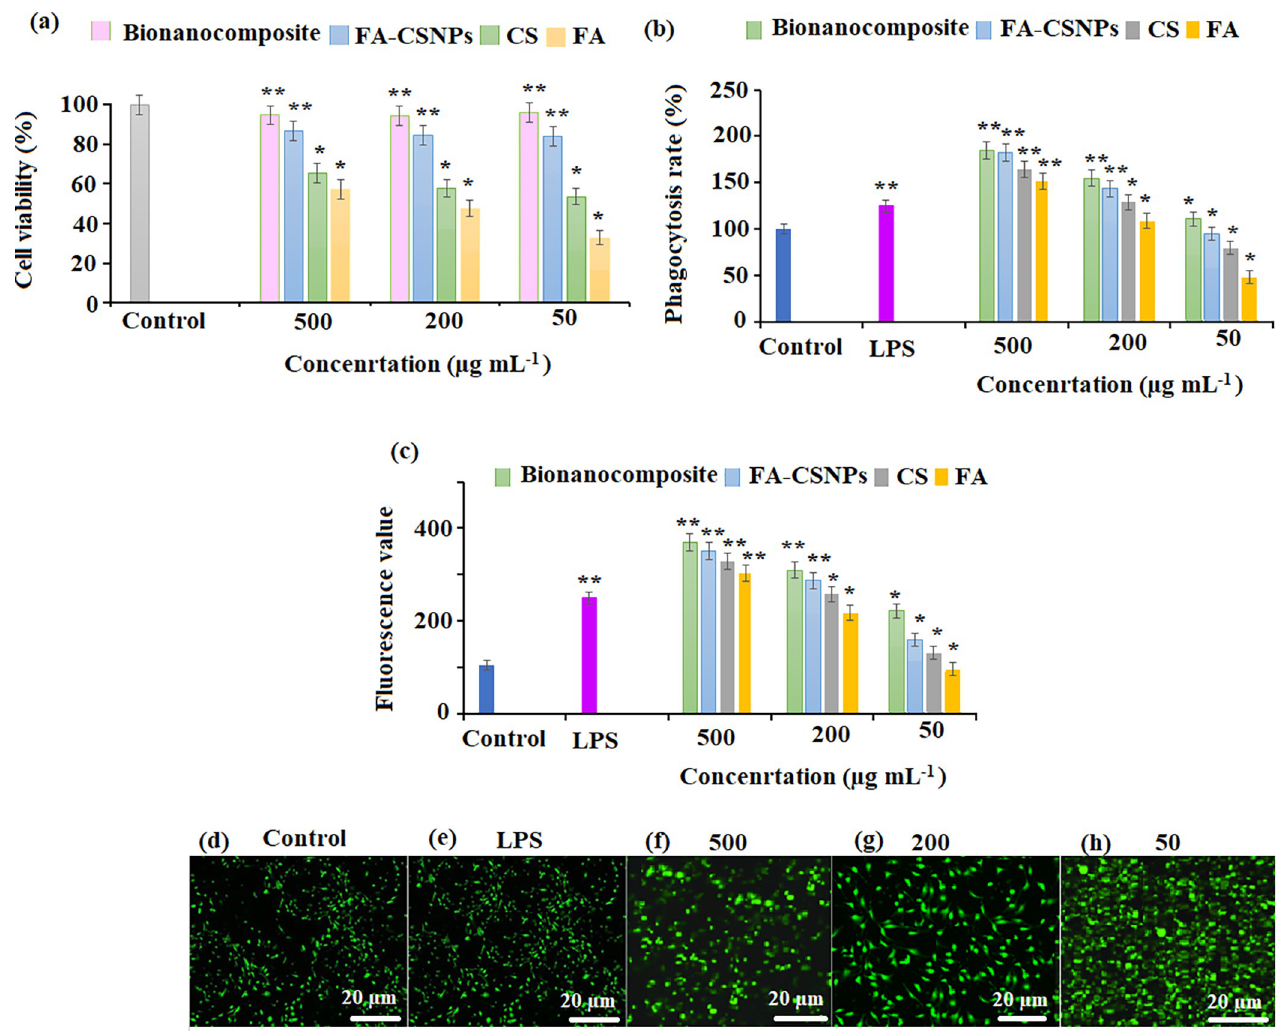
Fig 9. (a) Effect of FA, CS, FA–CSNPs, and bionanocomposite on the cell viability of RAW264.7 cells, (b) pinocytic and phagocytic activity of RAW264.7 cells, and (c) fluorescence values, (d–h) Microscopic fluorescence images of (d) control, (e) LPS, (f–h) bionanocomposite (500, 200, and 50 μ g mL –1 ) caused phagocytosis. The values are expressed as mean ± standard deviation (n = 3). Significant differences with control cells were calculated as * P < 0 . 05 or ** P < 0 . 01